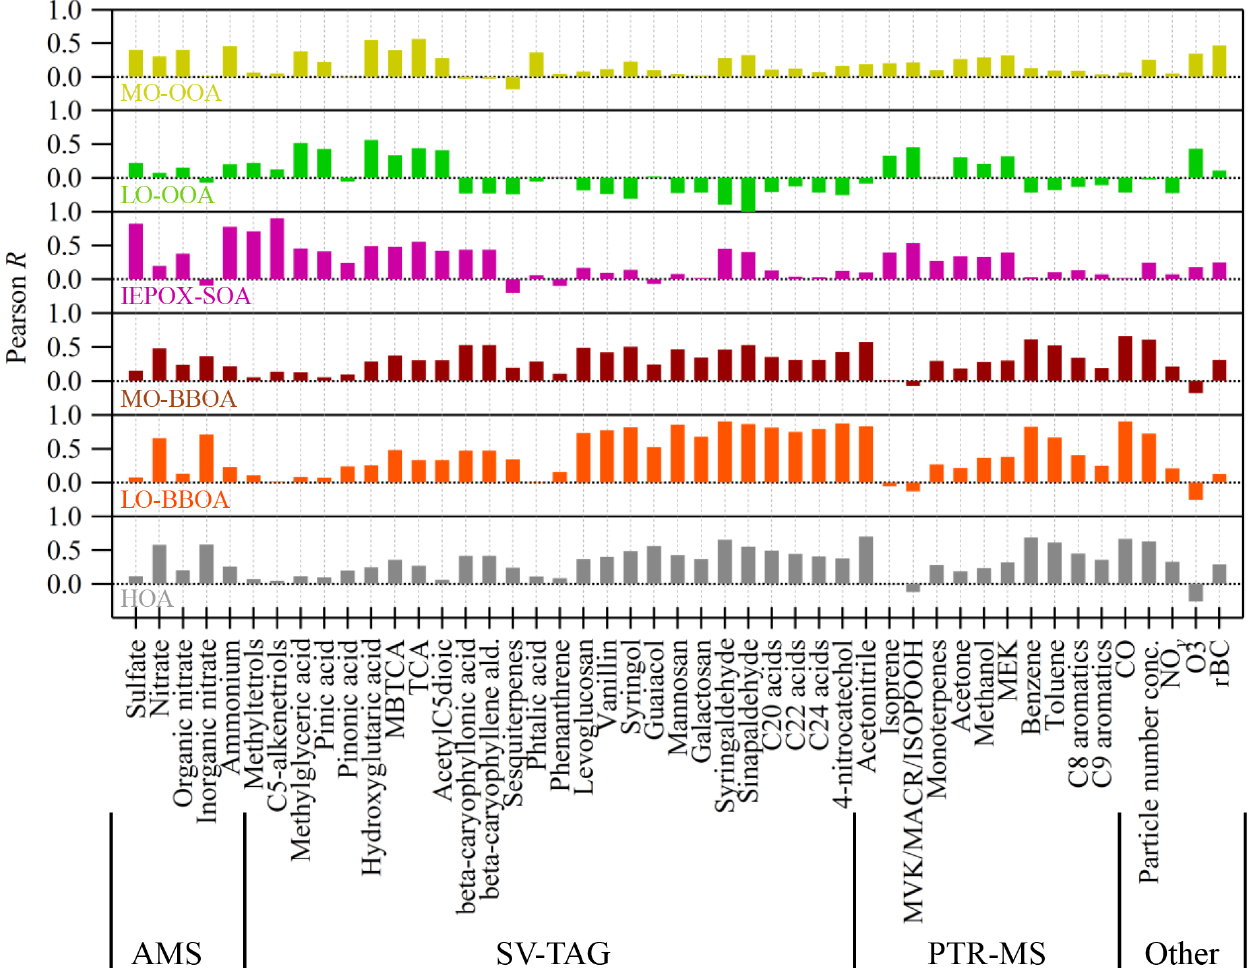
Figure 6. Pearson R correlations between the loading of each PMF factor and concentrations of selected measurements at the T3 site. Abbre- viations include tricarballylic acid (TCA), methyl-butyl-tricarboxylic acid (MBTCA), methyl vinyl ketone (MVK), methacrolein (MACR), isoprene hydroxyhydroperoxides (ISOPOOH), and rBC. SV-TAG measurements refer to particle-phase concentrations, except for sesquiter- penes which refer to total concentrations and mostly occurred in the gas phase. The C 8 and C 9 aromatics include the xylene and trimethyl- benzene isomers, respectively. The C 20 , C 22 , and C 24 acids include eicosanoic, docosanoic, and tetracosanoic acids,